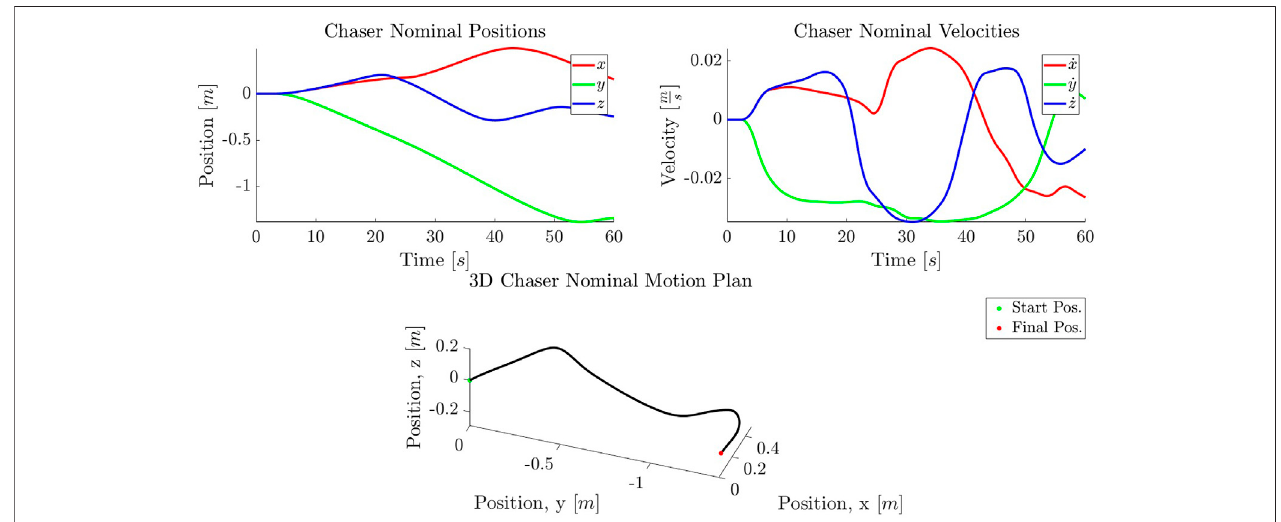
FIGURE11| A plannedtrajectoryin position (A) and velocity (B) foratri-axial tumble query with inputs supplied bythe Target estimation, with fi nalChaserposition and velocity equal to that of the MP. The 3D representation of the trajectory is given (C) . The trajectory is presented in the inertial frame.